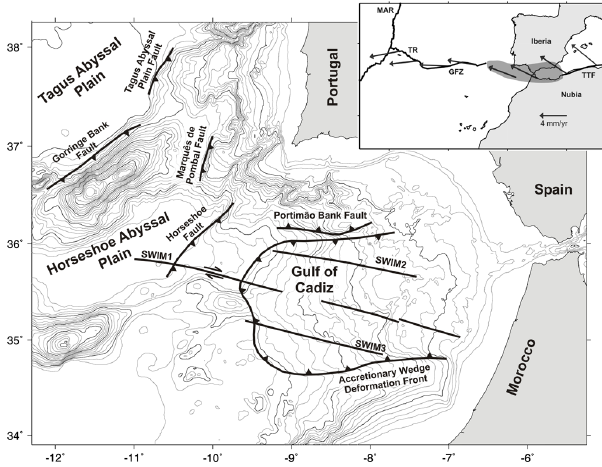
Fig. 1. Simplified tectonic map of the Gulf of Cadiz and neighbour- ing Abyssal Plains (see text for references). In the background we have the GEBCO (2003) (General Bathymetric Chart of the Oceans) bathymetry with highlighted contours every 1000m. Inset on the top right corner shows the well-identified segments of the Nubia- Eurasia plate boundary (thick black lines). The shaded area identi- fies the zone where this plate boundary is less constrained. The ar- rows show the relative movement of Nubia with respect to Eurasia at distinct locations of the boundary after Fernandes et al.